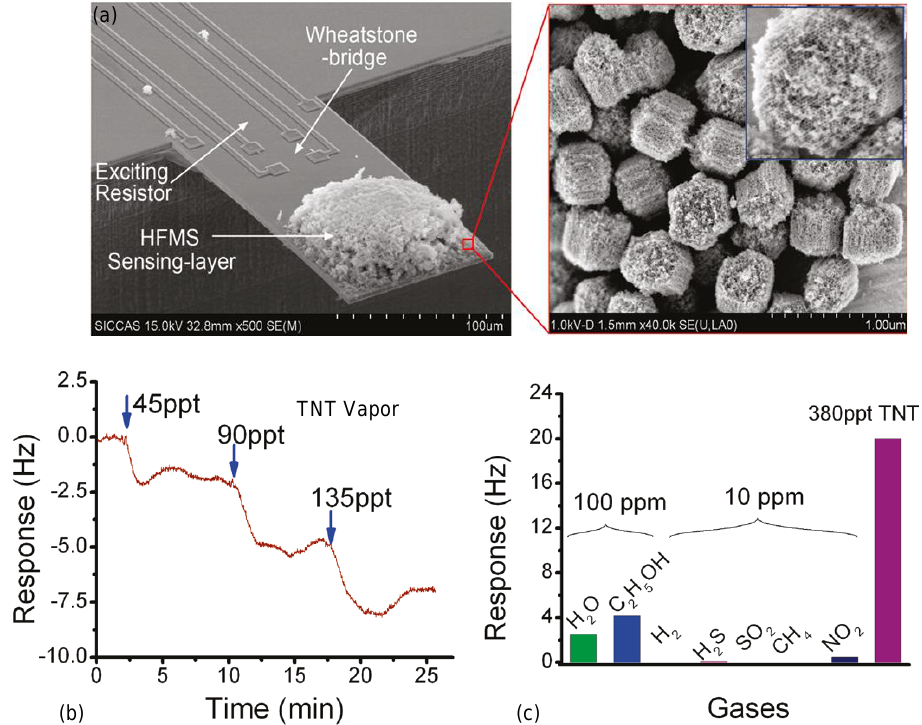
Figure 6. TNT vapor detection using a microcantilever sensor. ( a ) SEM images showing a microcan- tilever sensor with loaded HEMS nanomaterials. ( b ) Frequency responses of the microcantilever to TNT vapors at different contractions. ( c ) Sensor responses to various kinds of interfering gases compared with 380 ppt TNT vapor. Reprinted with permission from [42]. Copyright 2011 American Chemical Society.